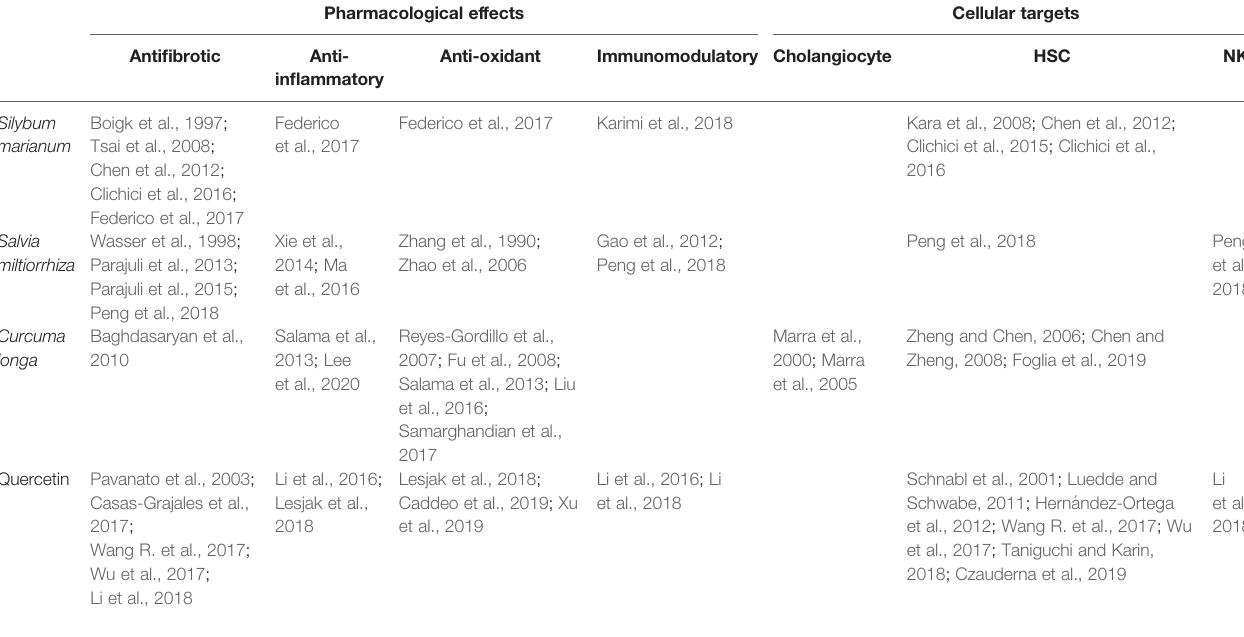
TABLE 1 | Summary of references on pharmacological effects and cellular targets of the herbal remedies Silybum marianum , Salvia miltiorrhiza , Curcuma longa, and quercetin discussed in this